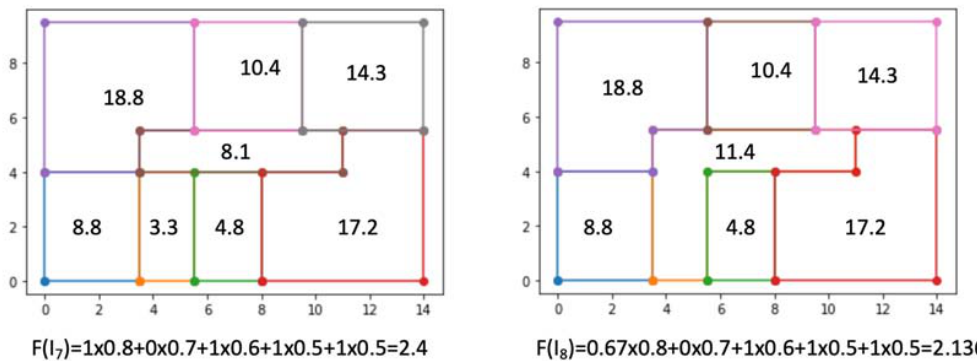
Figure 10. Two example floor plans I 7 and I 8 where only REQ1 had a different evaluation value.